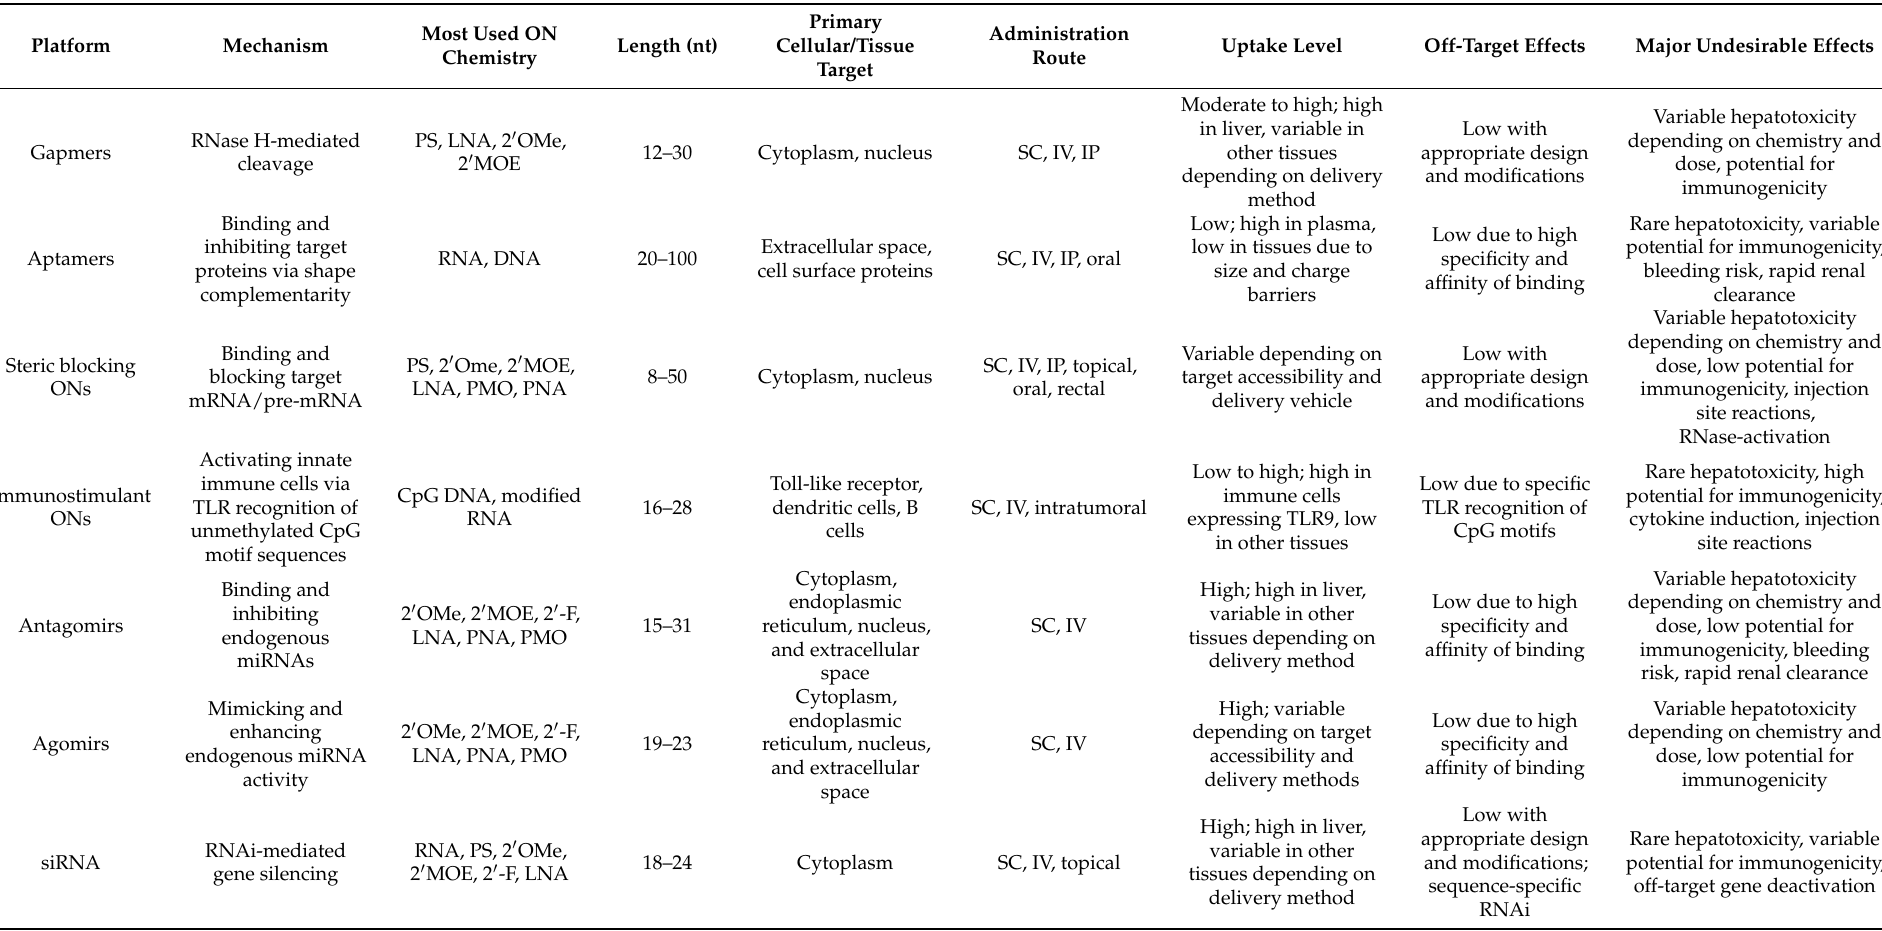
Table 1. Comparison of different ON platforms. The binding efficiency, tissue/cellular target, uptake level, off-target effects, liver toxicity, and immunogenicity of each platform can vary depending on the specific ON strategy used, the target RNA sequence, and other factors [11,29,39,60,103–108]. The information presented in this table are based on a general understanding of data from reported records and may vary depending on a case-by-case